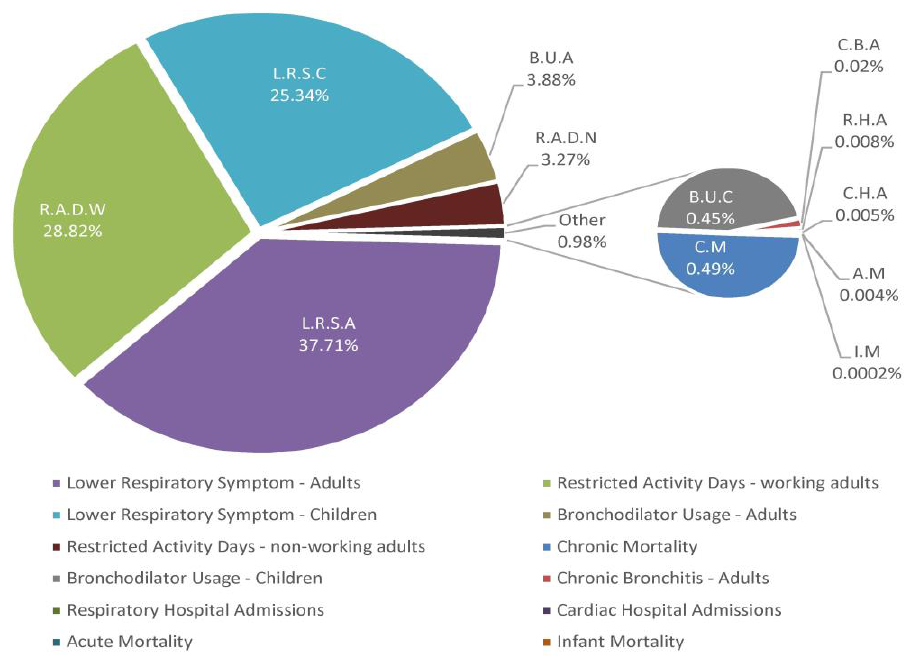
Figure 6. Share of each health impact in total cases from all the 61 power plants.